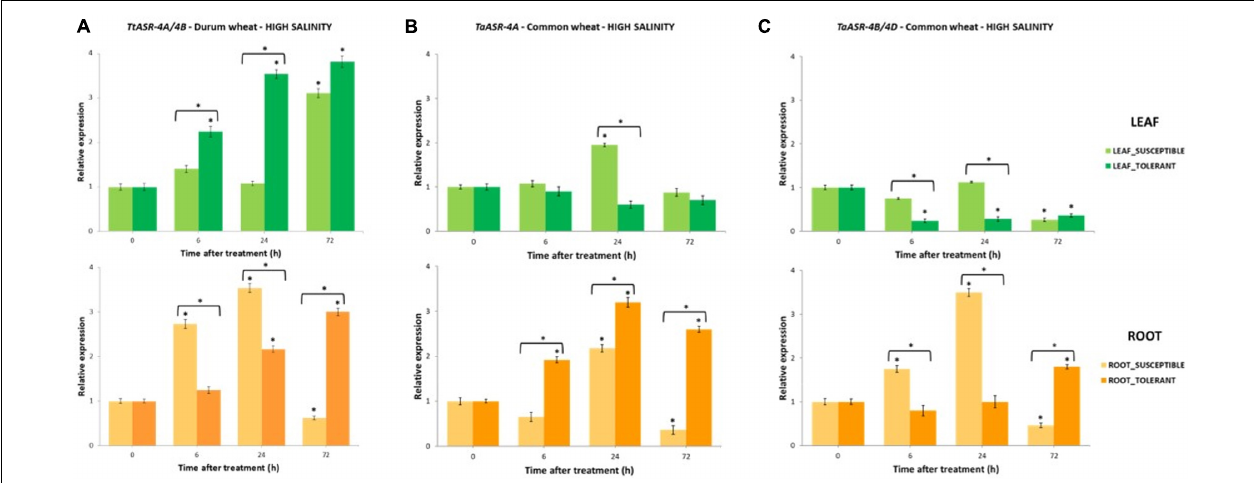
FIGURE 3 | The qRT-PCR time-course expression of ASR genes in salt-susceptible and salt-tolerant Tunisian genotypes of tetraploid and hexaploid wheat after 200 mM NaCl application. Gene expression was measured in leaves and roots at 0 (control, not treated, set to 1), 6-, 24-, and 72-h post-treatment. Expression values are reported as fold-changes relative to control, normalized against an internal reference ( Actin ). Data represent the mean ± SD of three technical replicates (vertical bars). Asterisks indicate data significantly different between samples and control (* on bars) or between susceptible and tolerant genotypes (* over two bars), according to Student’s t -test (* p < 0.05). (A) Expression profile of TtASR genes from 4A and 4B chromosomes of durum wheat in salt-susceptible (HmiraK11835 S ) and salt-tolerant (HmiraK11857 T ) genotypes. (B) Expression profile of TaASR gene from 4A chromosome of common wheat in salt-tolerant (Ta001 T ) and